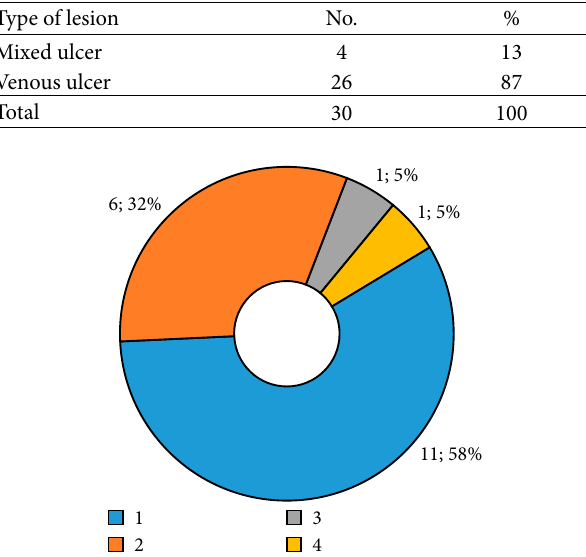
Table 6: Time of evolution of lesions.